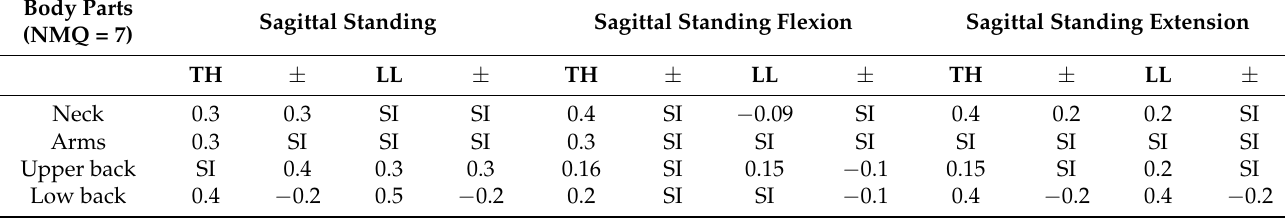
Table 3. The results of statistical correlations between the prevalence and location of musculoskeletal pain (NMQ = 7) and angles of anteroposterior spinal curvatures and differences between physiological norms of thoracic kyphosis and lumbar lordosis angles (Medi